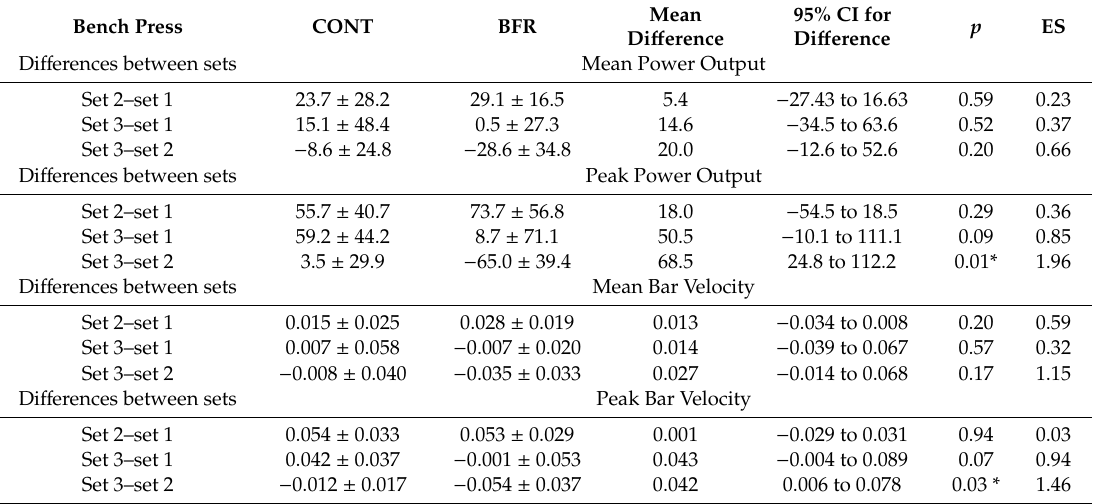
Figure 4. Mean bar velocity for BFR and CONT conditions during three successive sets of the bench press exercise. Table 2. The comparison of di ff erences in particular sets between BFR and CONT conditions.